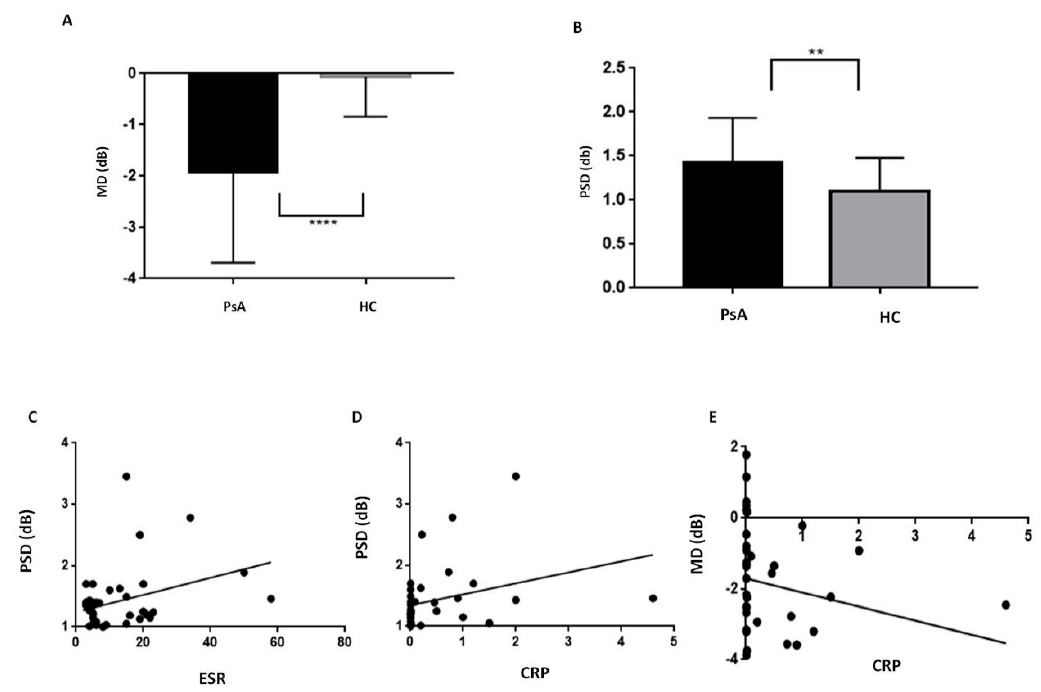
Figure 2. Standard Automated Perimetry in patients with psoriatic arthritis sine psoriasis. PsA, Psoriatic Arthritis; HC, healthy controls; MD, Mean Deviation, PSD, Pattern Standard Deviation; ESR, Erythrocyte sedimentation rate; CRP, C-Reactive Protein. Standard automated perimetry demonstrated in PsA patients a lower MD (panel ( A ), p < 0.0001) and a higher PSD (panel ( B ), p = 0.005) in comparison with the HC. In PsA patients, PSD was positively related with ESR (panel ( C ), r = 0.3, p = 0.04) and CRP (panel ( D ), r = 0.4, p = 0.01) while MD was related with CRP (panel ( E ), r = − 0.4, p = 0.01). Continuous variables were compared using the parametric unpaired t-test or the nonparametric Mann–Whitney U test when appropriate. The significance of any correlation was determined by Pearson correlation test or Spearman’s rank correlation coefficient where appropriate.